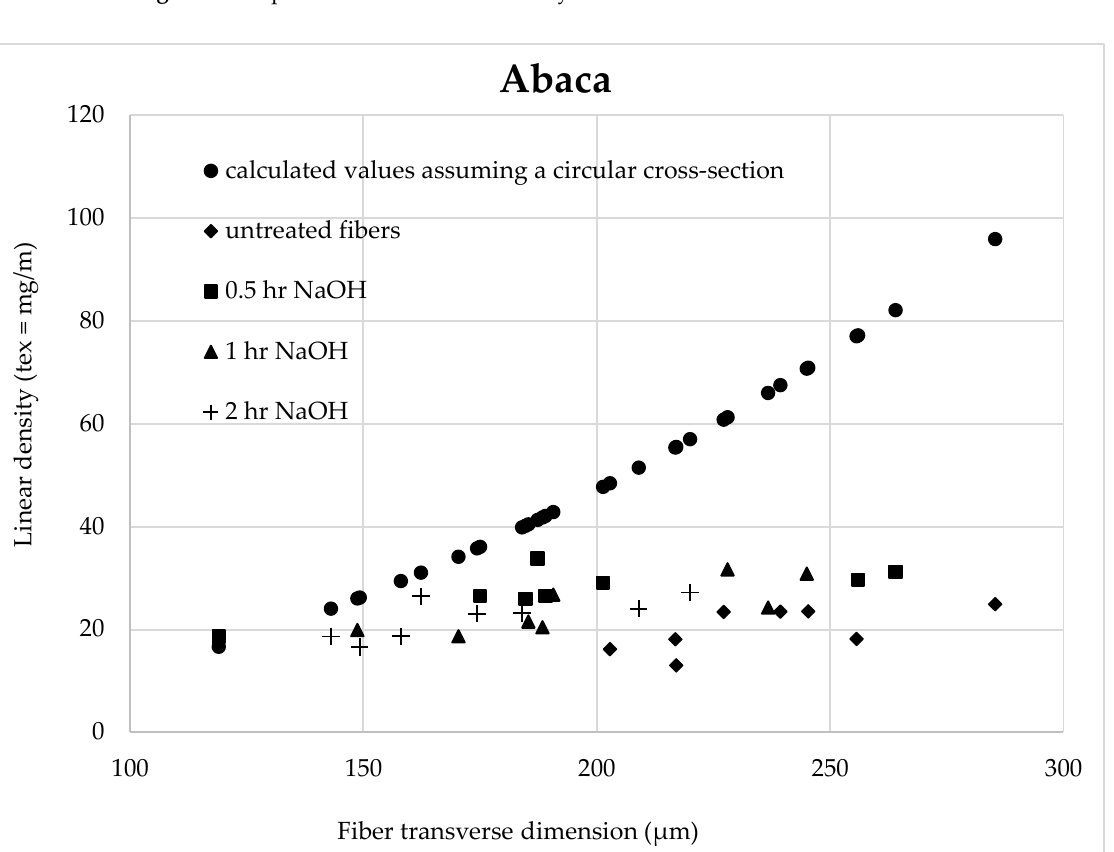
Figure 13. Dependence of the linear density on the transverse dimension of the coir.